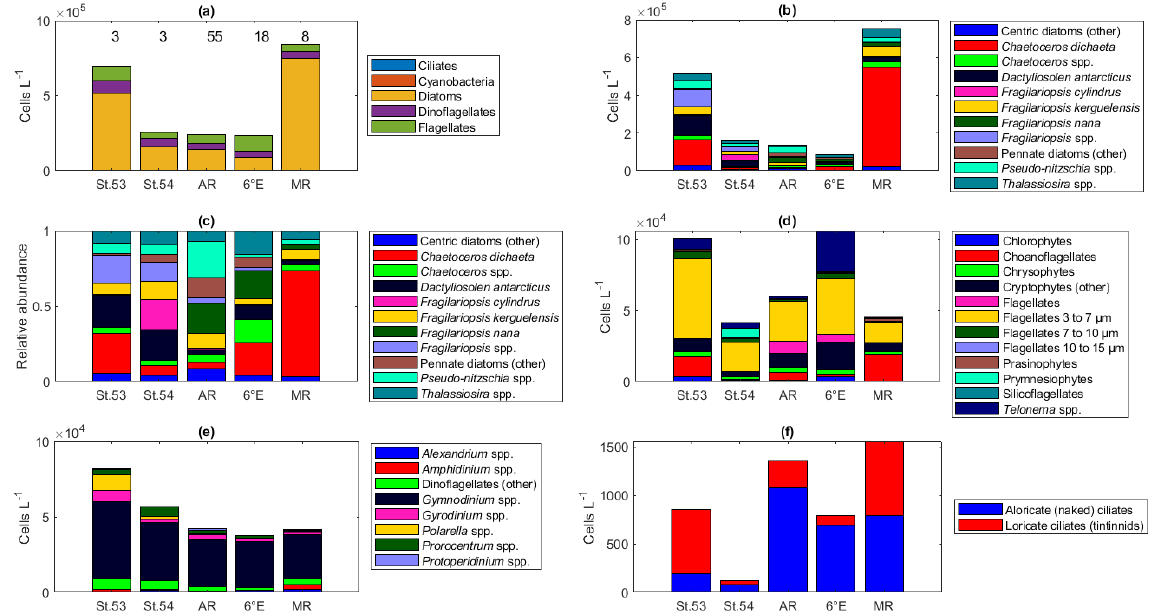
Figure 2. Abundance of different protist groups and species for the (a) main taxa, (b) diatoms, (c) relative abundance of diatoms, (d) flagellates, (e) dinoflagellates, and (f) ciliates. In panel (a) , the number of samples used for the average abundances is shown at the top of the figure (the numbers apply to all the figures). In panels (c) and (d) , the genera Fragilariopsis and Pseudo-nitzschia belong to pennate diatoms, and thus pennate diatoms are shown with colors pink/yellow to cyan. St.53: station 53, St.54: station 54, AR: Astrid Ridge, 6E: 6 ◦ E transect, MR: Maud Rise.